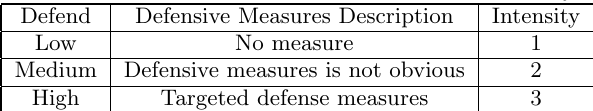
Table 2: The Information of Defensive Intensity Defend Defensive Measures